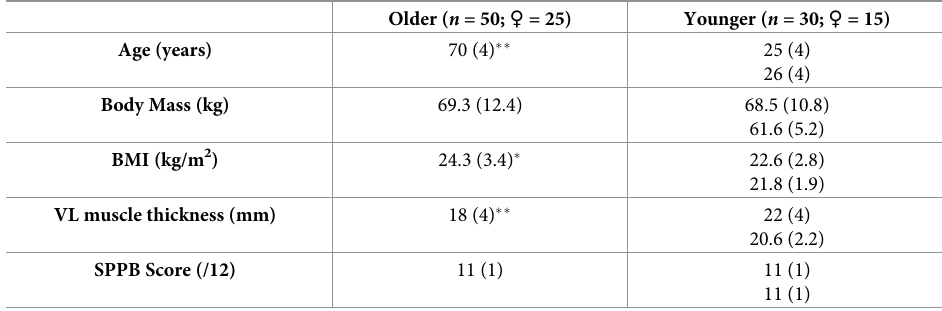
Table 1. Participant